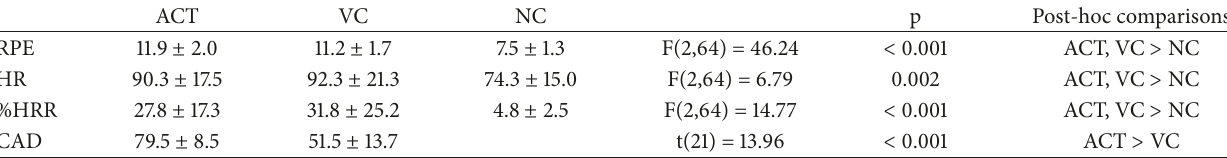
Table 2: Mean differences in RPE, HR, %HRR, and CAD across